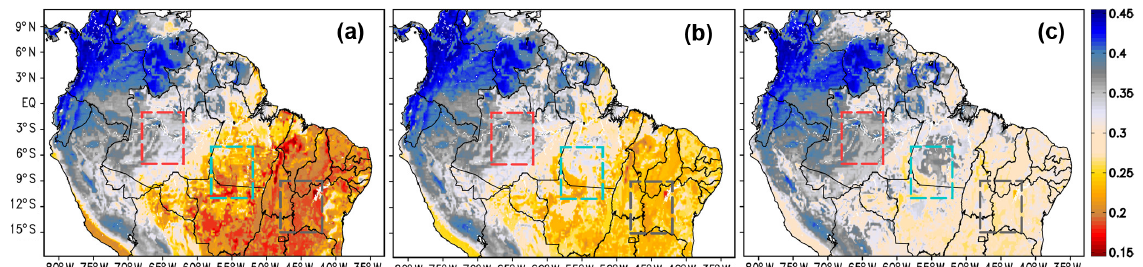
Figure 5. Monthly mean soil moisture (m 3 m − 3 ) during September 2010 at three soil levels: (a) 0.35m, (b) 1.00m, and (c) 4.25m. The rectangles depict areas with a predominance of forest and moist soil (red), forest and dry soil (blue), and cerrado with dry soil (gray).